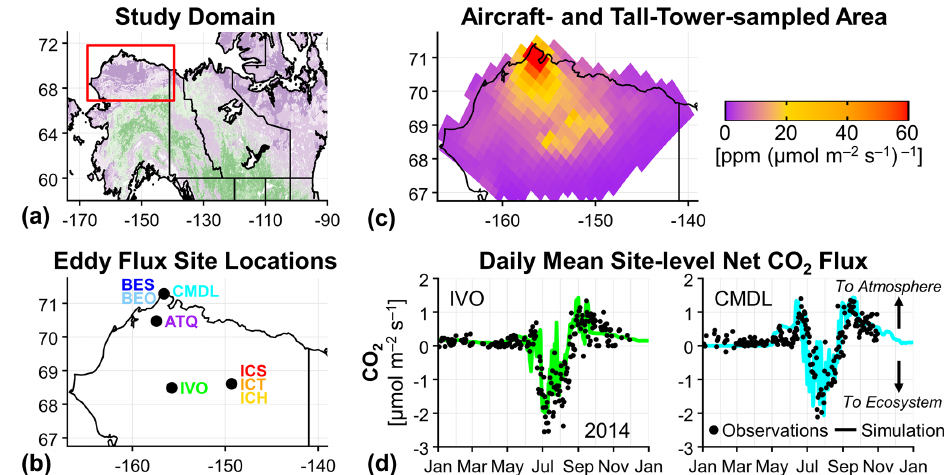
Figure 1. Alaska North Slope study region, eddy flux site locations, area sampled by aircraft and the tower, and example results from the eddy flux site measurement–model comparison. (a) North Slope region (red box) within Alaska and northwestern Canada; tundra ar- eas are shown in purple, and boreal forest areas are shown in green (Luus et al., 2017). (b) Location of eddy flux measurement sites on the Alaska North Slope used in this analysis. (c) The 10d WRF-STILT (Weather Research and Forecasting–Stochastic Time-Inverted La- grangian Transport) footprints used to sample CO 2 flux models, summed for all aircraft and tall-tower CO 2 observations used in this analysis; colors represent values greater than 0 and are saturated at 60ppm ( µmolm − 2 s − 1 ) − 1 , and the maximum value near Utqia˙gvik, Alaska, is 324ppm ( µmolm − 2 s − 1 ) − 1 . (d) Time series of the observed (black dots) and simulated (colored lines) site-level daily mean net CO 2 flux for 2014 at the Ivotuk (IVO; left) and Climate Monitoring and Diagnostics Laboratory (CMDL; right) eddy flux measurement sites, where site- level Tundra Vegetation Photosynthesis and Respiration Model (TVPRM) net CO 2 flux simulations are driven by North American Regional Reanalysis (NARR) meteorology and the solar-induced chlorophyll fluorescence (SIF) product from the contiguous SIF (CSIF) dataset. Pos- itive net CO 2 flux values indicate CO 2 fluxes into the atmosphere throughout this study. A comparison for all eight eddy flux sites is provided in Fig. S1 in the